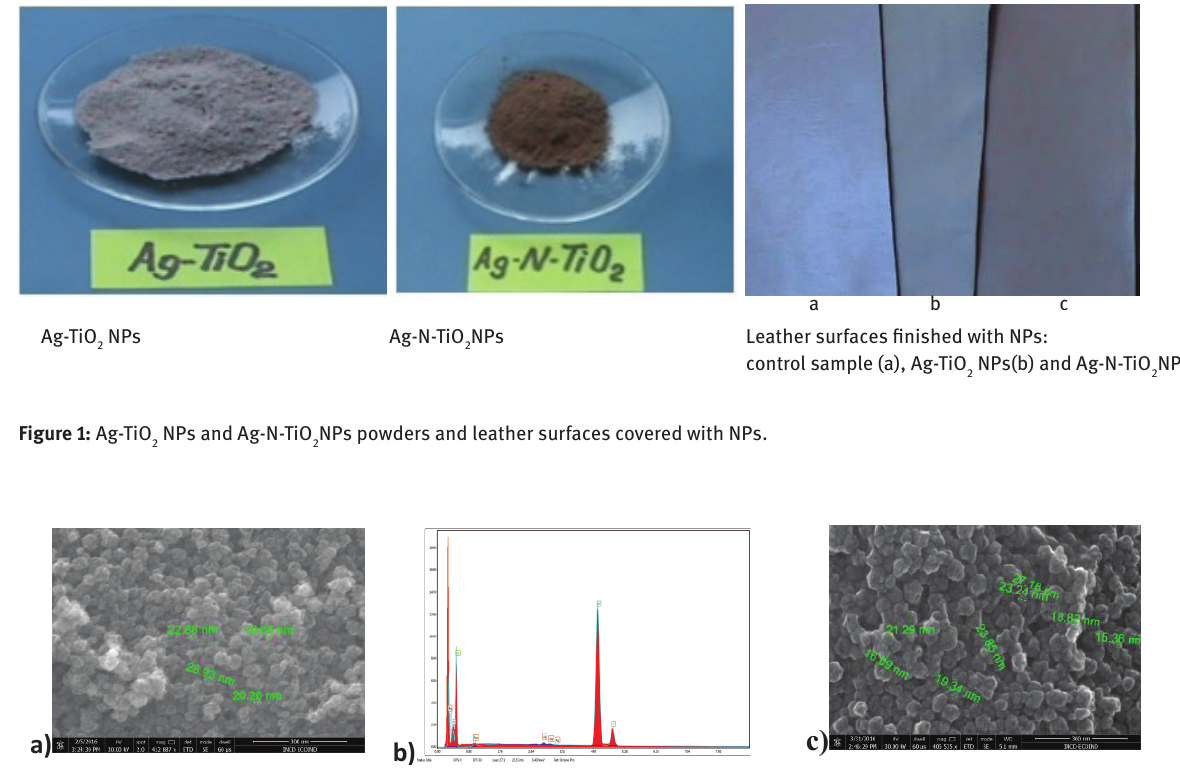
Figure 2. SEM images of Ag-N-TiO 2 (a) and Ag-TiO 2 (c) nanopowders and identification of Ag doping on N-TiO 2 NP surface(b) by EDX Figure 2: SEM images of Ag-N-TiO 2 (a) and Ag-TiO 2 (c) nanopowders and identifi cation of Ag doping on N-TiO 2 NP surface(b) by